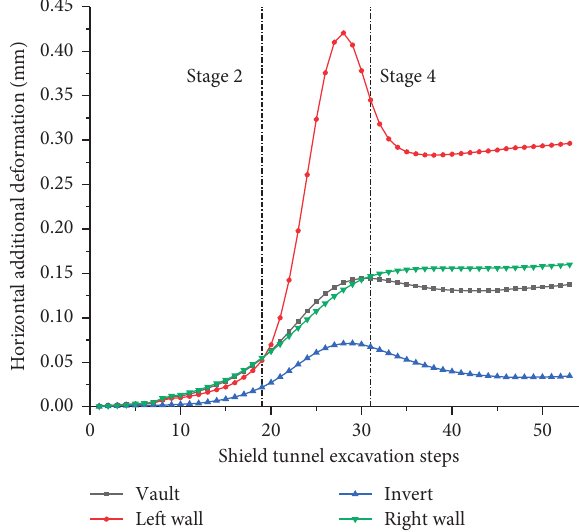
Figure 24: Support structure of the horizontal additional displacement